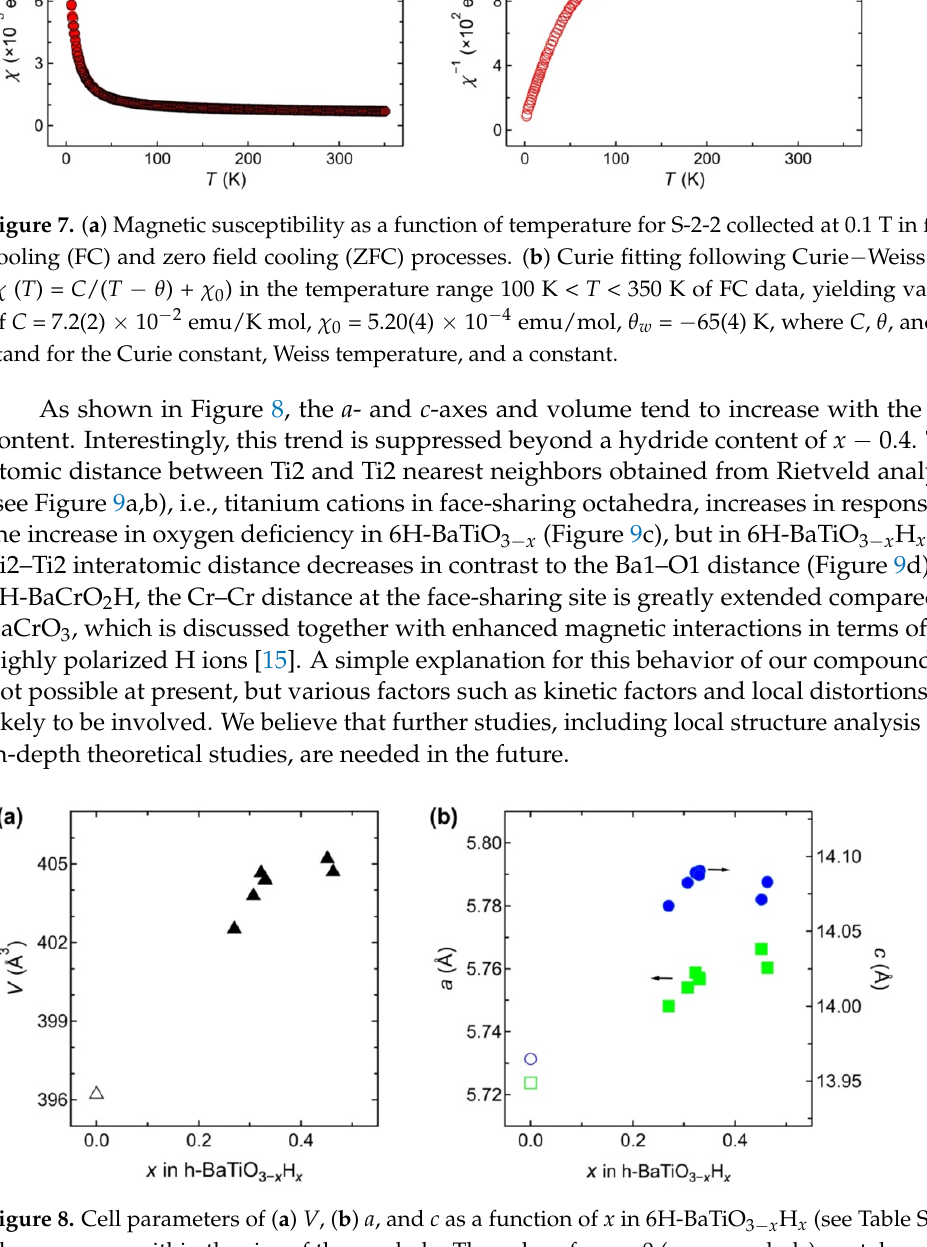
Figure 7. ( a ) Magnetic susceptibility as a function of temperature for S-2-2 collected at 0.1 T in field Figure 6. Quadrupole mass spectrometry of H 2 during heating of the S-2-2 which is prepared by ( T ) = C /( T − θ ) + χ 0 ) in the temperature range 100 K < T < 350 K of FC data, yielding values of C = twice heat treatment at 1000 °C for 10 h and subsequent hydrogenation with CaH 2 at 520 °C for 120 7.2(2) × 10 − 2 emu/K mol, χ 0 = 5.20(4) × 10 − 4 emu/mol, θ w = − 65(4) K, where C , θ , and χ 0 stand for the h.